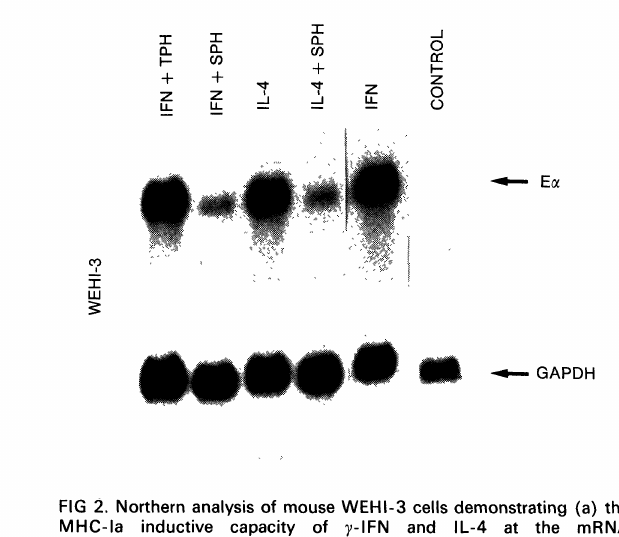
FIG 2. Northern analysis of mouse WEHI-3 cells demonstrating (a) the MHC-la inductive capacity of ?-IFN and IL-4 at the mRNA level, and (b) the pathways followed in up-regulating class II antigens (E=). The actions of both ?-IFN and IL-4 can be inhibited by the PKC inhibitor sphingosine (SPH). Theophylline (TPH), which blocks the Ca2//Cam pathway, does not have any